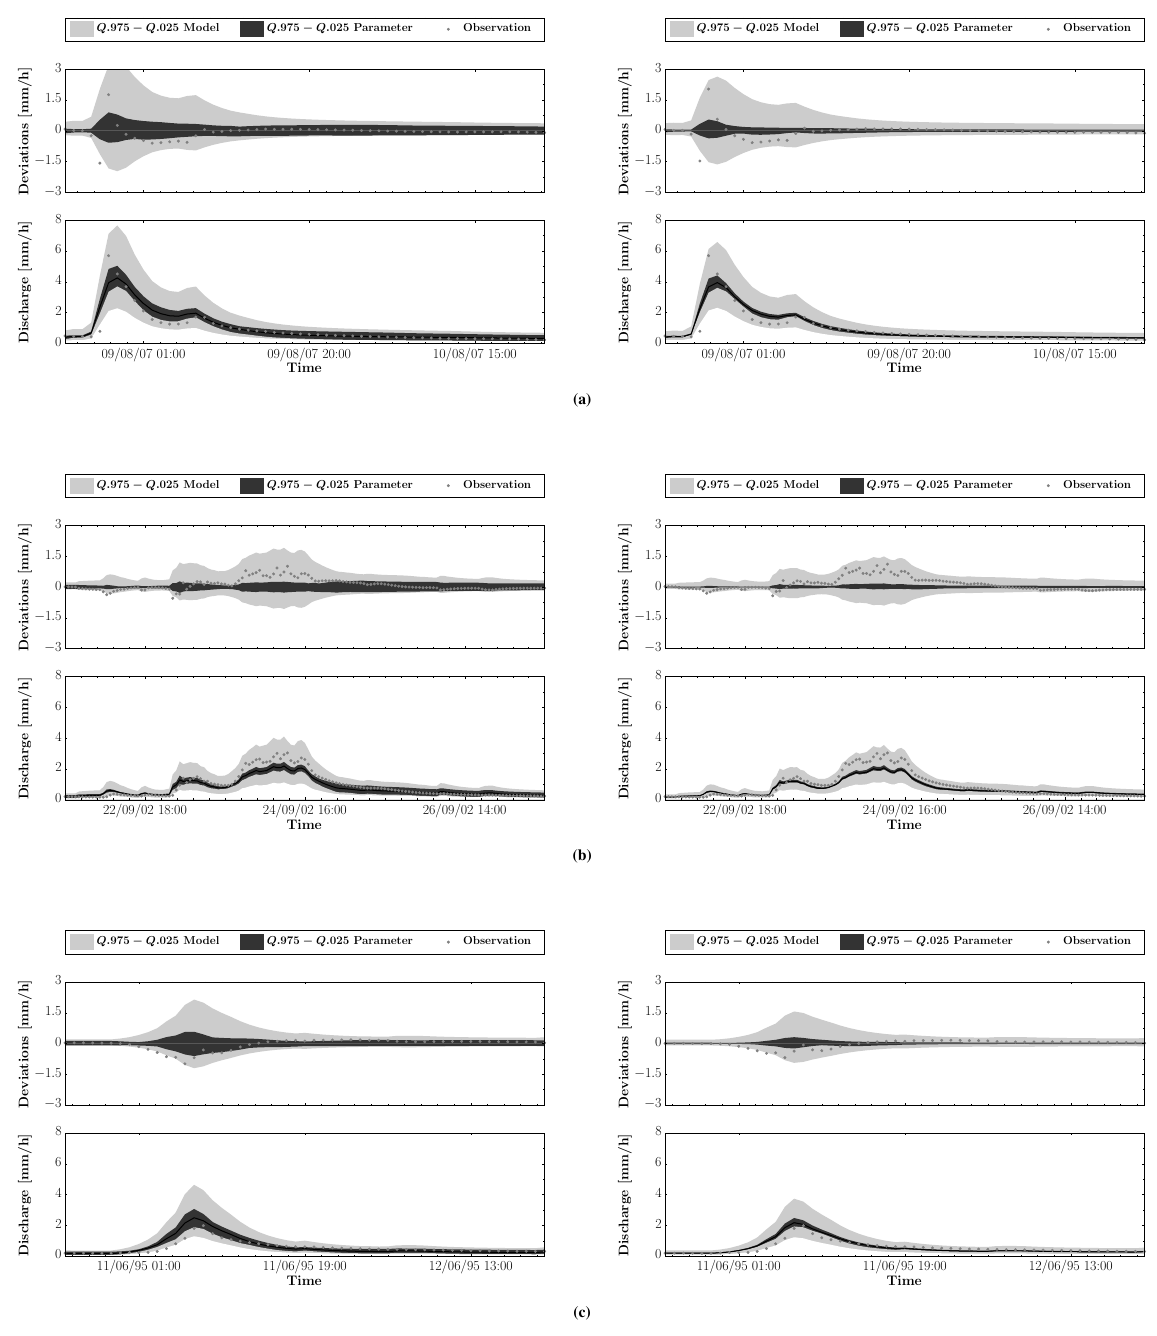
Fig. 18: Hydrograph prediction uncertainty associated with the uncertainty in the model (lighter shading) and parameter estimates (darker shading) for the flood events 4 (a) , 12 (b) and 19 (c) , estimated by A-ROPE (left column) and ROPE-PSO (right column). The dots correspond to the observed streamflow data. The shaded areas of uncertainty correspond to the 95% confidence intervals.